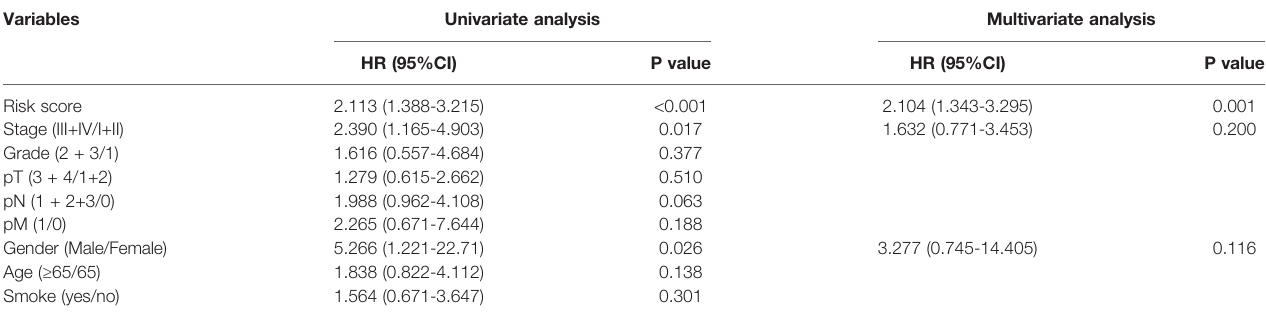
TABLE 1 | Univariate and Multivariate cox regression analysis-TCGA cohort. Variables Univariate analysis Multivariate